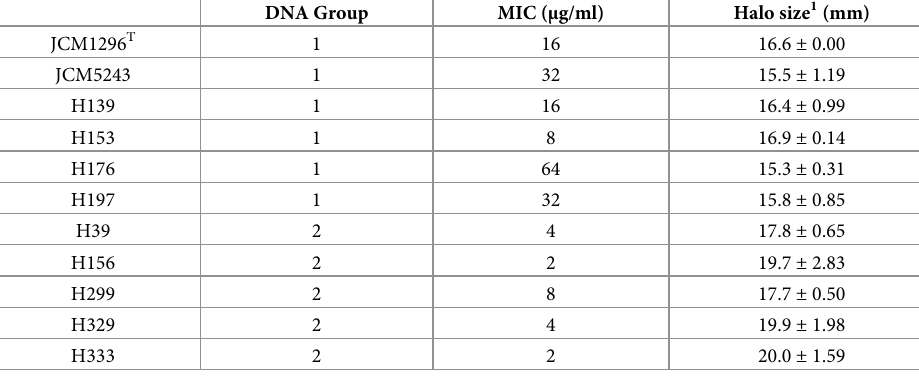
Table 2. Susceptibility to nisin A by MIC and direct assay